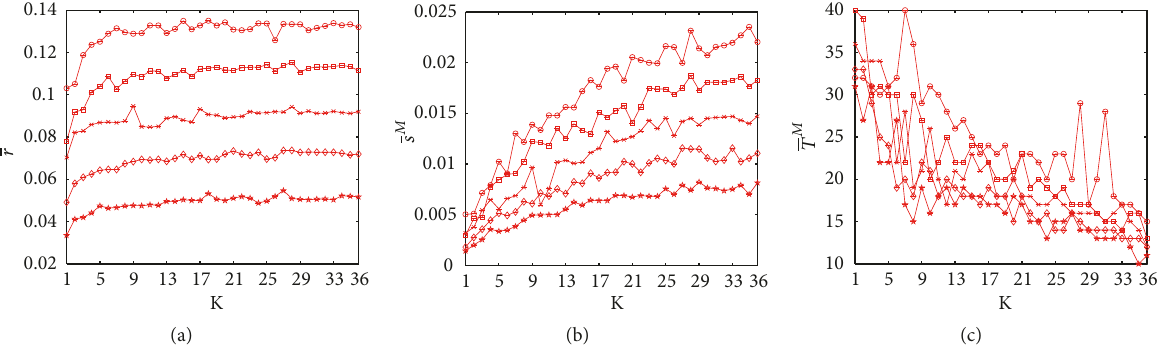
Figure 4: Three quantities of rumor propagation in PolBlogs: (a) the average propagation size, (b) the average peak prevalence, and (c) the arrival time of the average peak prevalence when the spreading rate 𝛼 = 0.1(𝑠𝑡𝑎𝑟𝑠) , 𝛼 = 0.125(𝑑𝑖𝑎𝑚𝑜𝑛𝑑𝑠) , 𝛼 = 0.15(𝑓𝑜𝑟𝑘𝑠) , 𝛼 = 0.175(𝑠𝑞𝑢𝑎𝑟𝑒𝑠) , and 𝛼 = 0.2(𝑐𝑖𝑟𝑐𝑙𝑒𝑠) , respectively, and the decay rate 𝛽 = 1 . The performance of nodes in the higher layer is better.